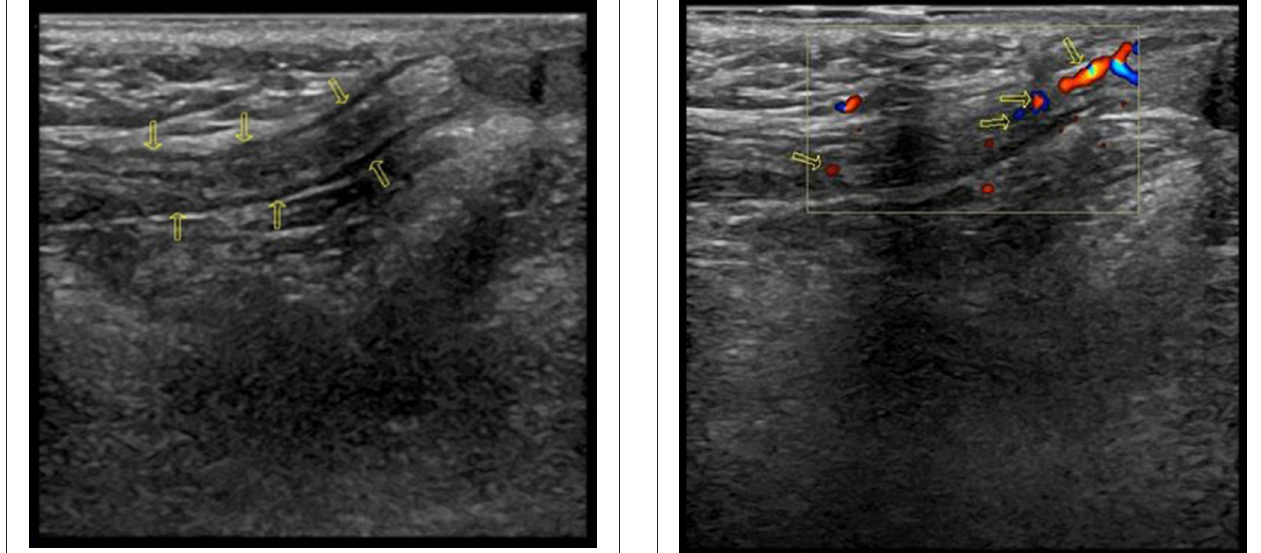
FIGURE 2 | Color Doppler Flow Imaging (CDFI) showed the flow